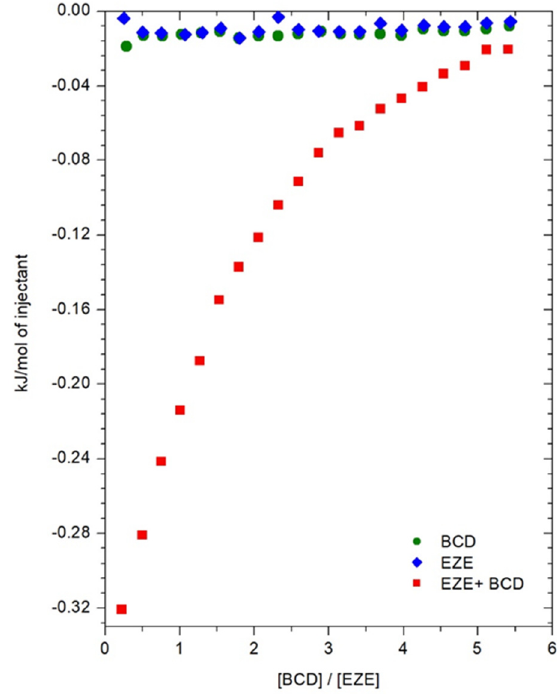
Figure 15. Thermograms describing energetic effects during the titration of a solution of ezetimibe with a solution of β -cyclodextrin ( ■ ), dilution of ezetimibe ( ♦ ), and dilution of β -cyclodextrin ( ● ).